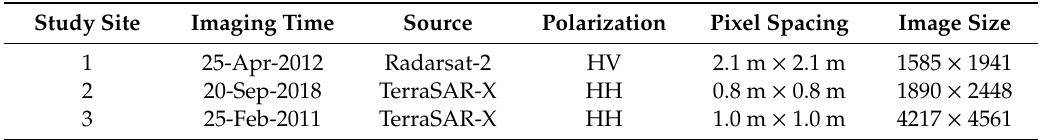
Table 1. The basic information of test